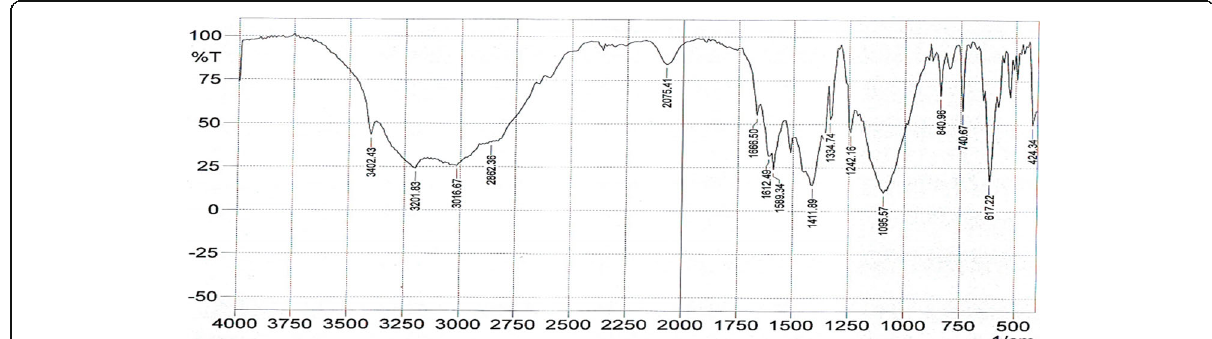
Fig. 7 The FT-IR spectroscopy for the killer toxin